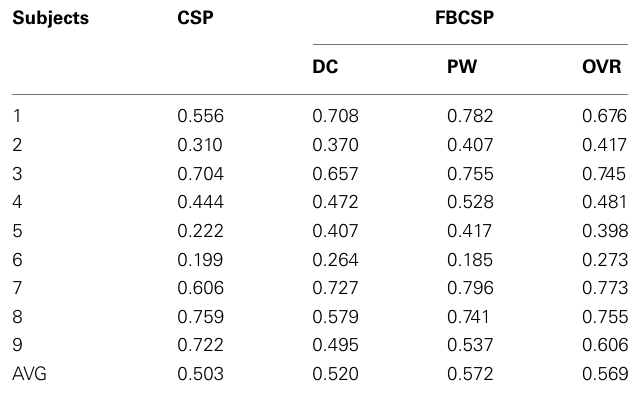
Table 2 | Classification results from using CSP and the 3 approaches of multi-class extensions to FBCSP algorithm on the unseen evaluation data from BCI Competition IV Dataset 2a.